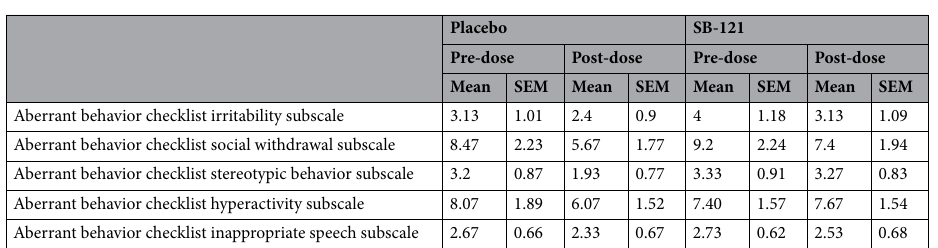
Table 6. Pre- and post-dose data for ABC. ABC Aberrant Behavior Checklist, SEM standard error of the mean.